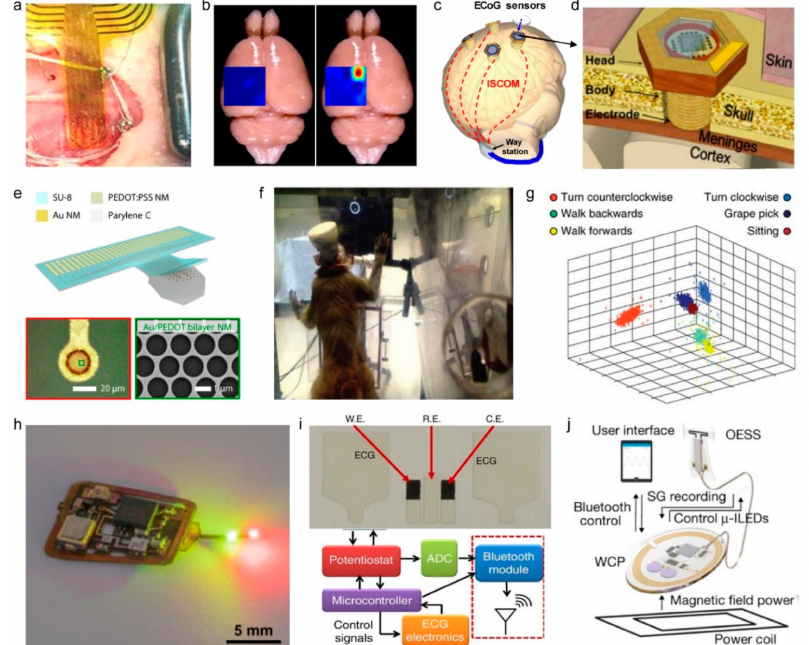
Figure 8. Neural interfaces ( a − g ) and physiological monitoring devices ( h − j ). ( a ) Implanted